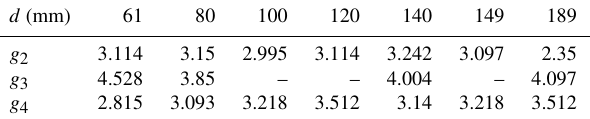
Table 8. Computed kH values from the measured wave period (see Table 7) and the Airy dispersion relation 2 π/T = for test cases d = 61 , 80 , 100 , 120 , 140 , 149, and